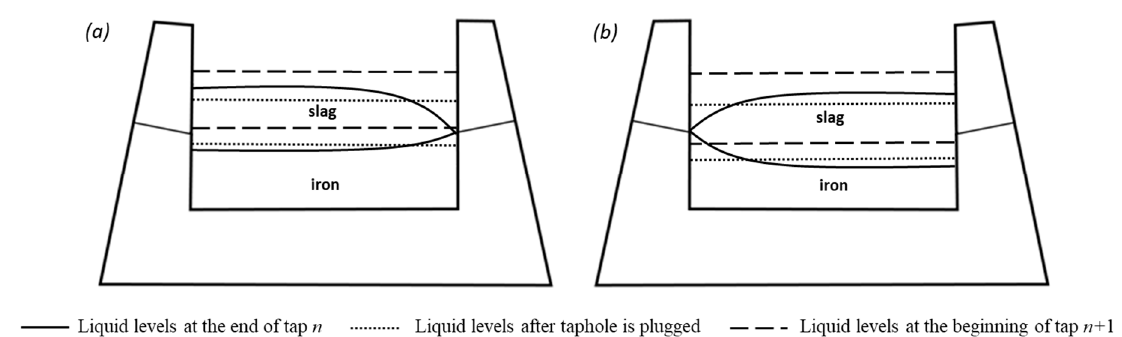
Figure 1. Illustration of two cases of slag delay: ( a ) positive slag delay (for the left taphole), ( b ) negative slag delay (for the right taphole).